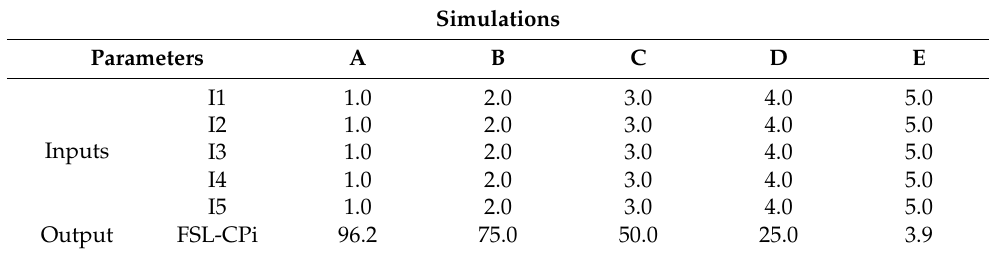
Table 3. Fuzzy logic system (FSL-CPi) simulations.